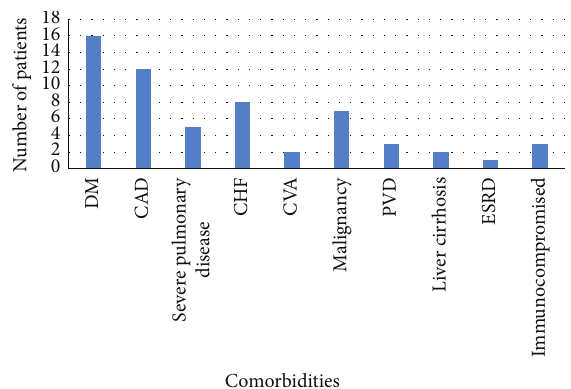
Figure 2: Comorbidities in patients with hyperuricemia and AKI.